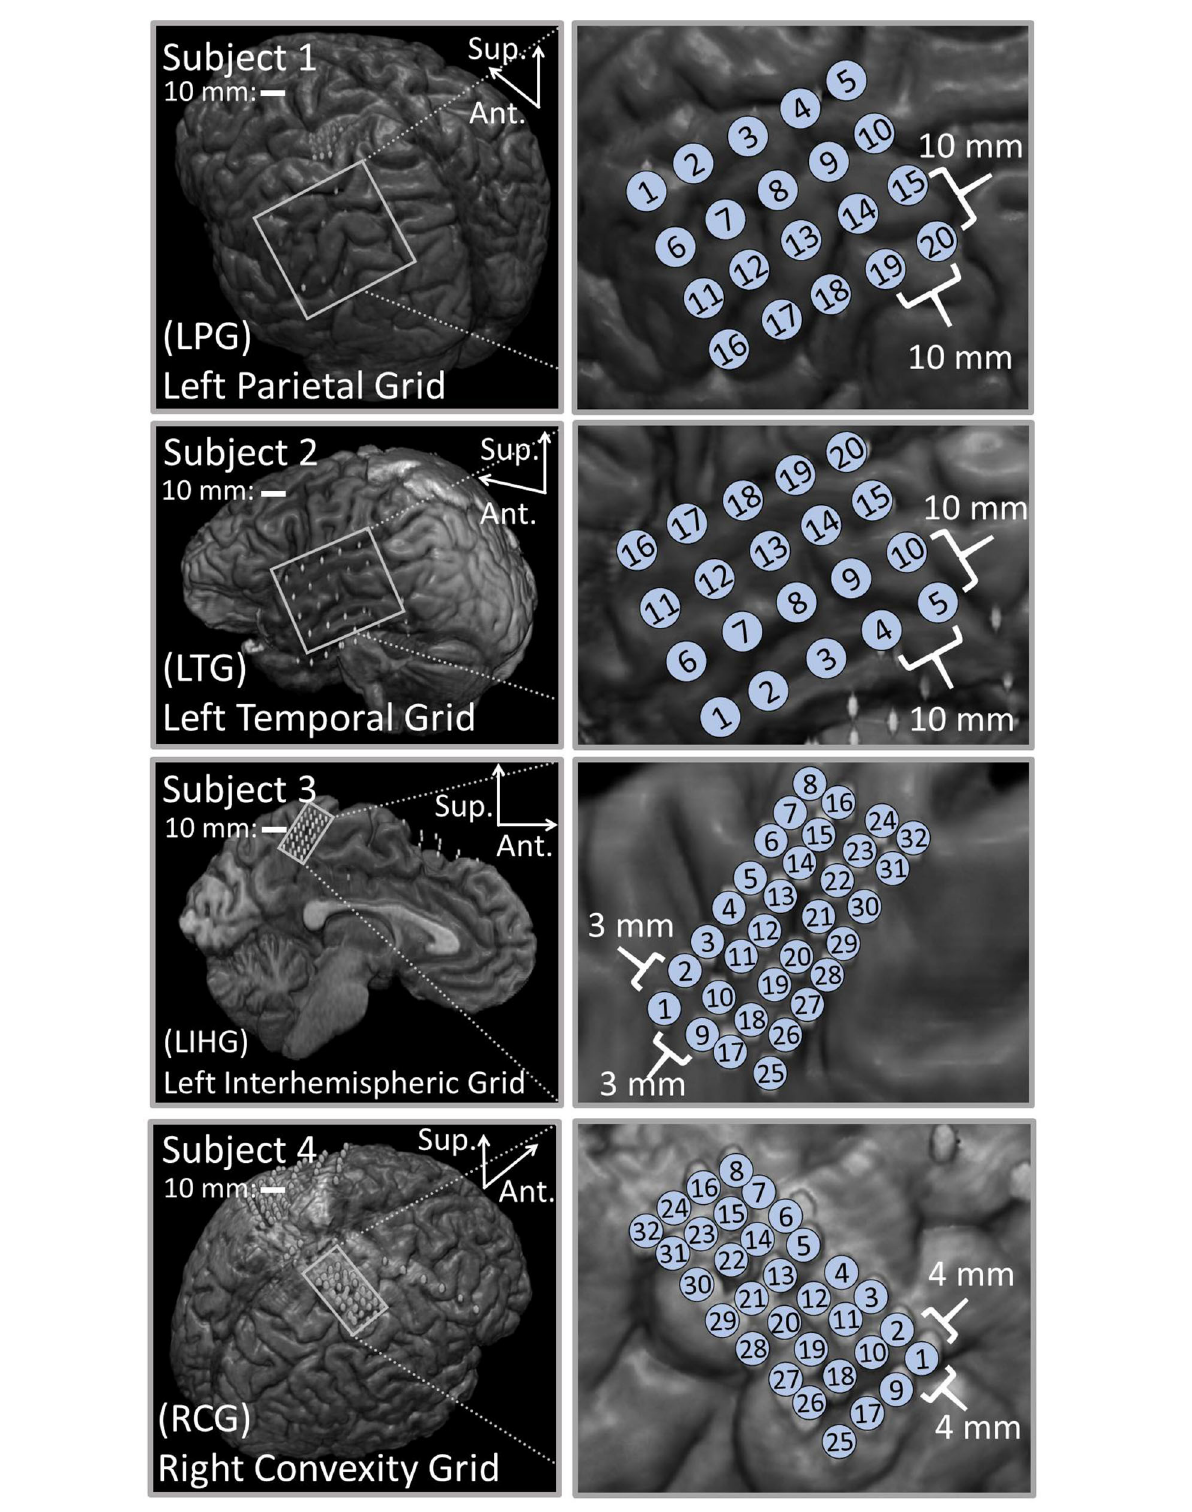
FIGURE1 Co-registration of electrodes segmented from CT images and brain segmented from MRI. (Left) Co-registration image for each subject, with the representative grid outlined in white. Note that the points representing electrodes are not to scale. Also note that the co-registration image for Subject 3 shows a left hemisphere (sagittal plane) with electrodes in the inter-hemispheric fissure. (Right) Insets of representative grids with electrode numbers encircled. The label size is not related to the electrode